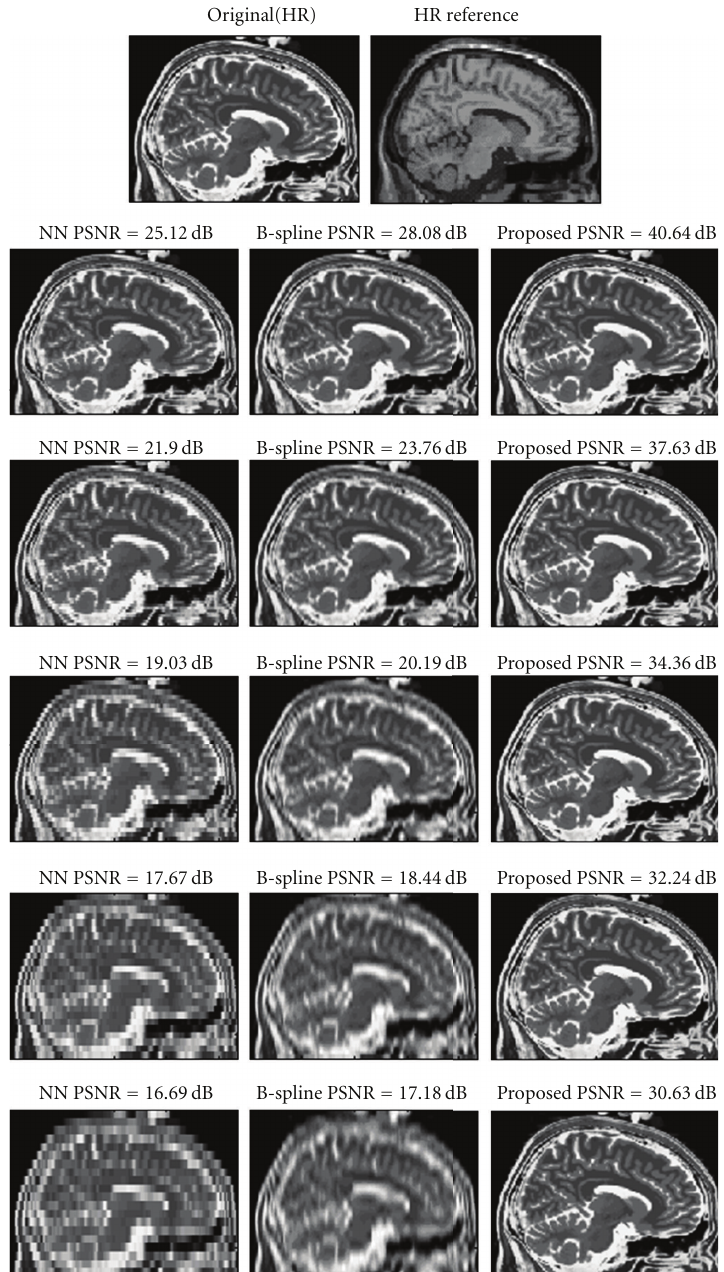
Figure 3: A sagittal slice for the normal anatomy case. From top to bottom, results with di ff erent slice thicknesses (2, 3, 5, 7, 9mm) and from left to right, the NN reconstruction, the B-Spline reconstruction, and the proposed method.